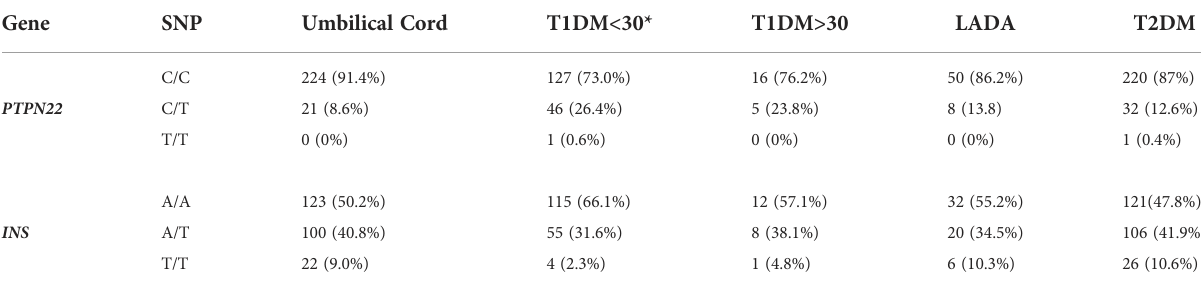
*distribution among genotypes is signi fi cantly different (p<0.05) from LADA. SNP: single nucleotide polymorphism; PTPN22: Protein Tyrosine Phosphatase Non-Receptor Type 22 gene; INS: Insulin gene; T1DM: Type 1 Diabetes Mellitus; LADA: Latent Autoimmune Diabetes of the Adult; T2DM: Type 2 Diabetes